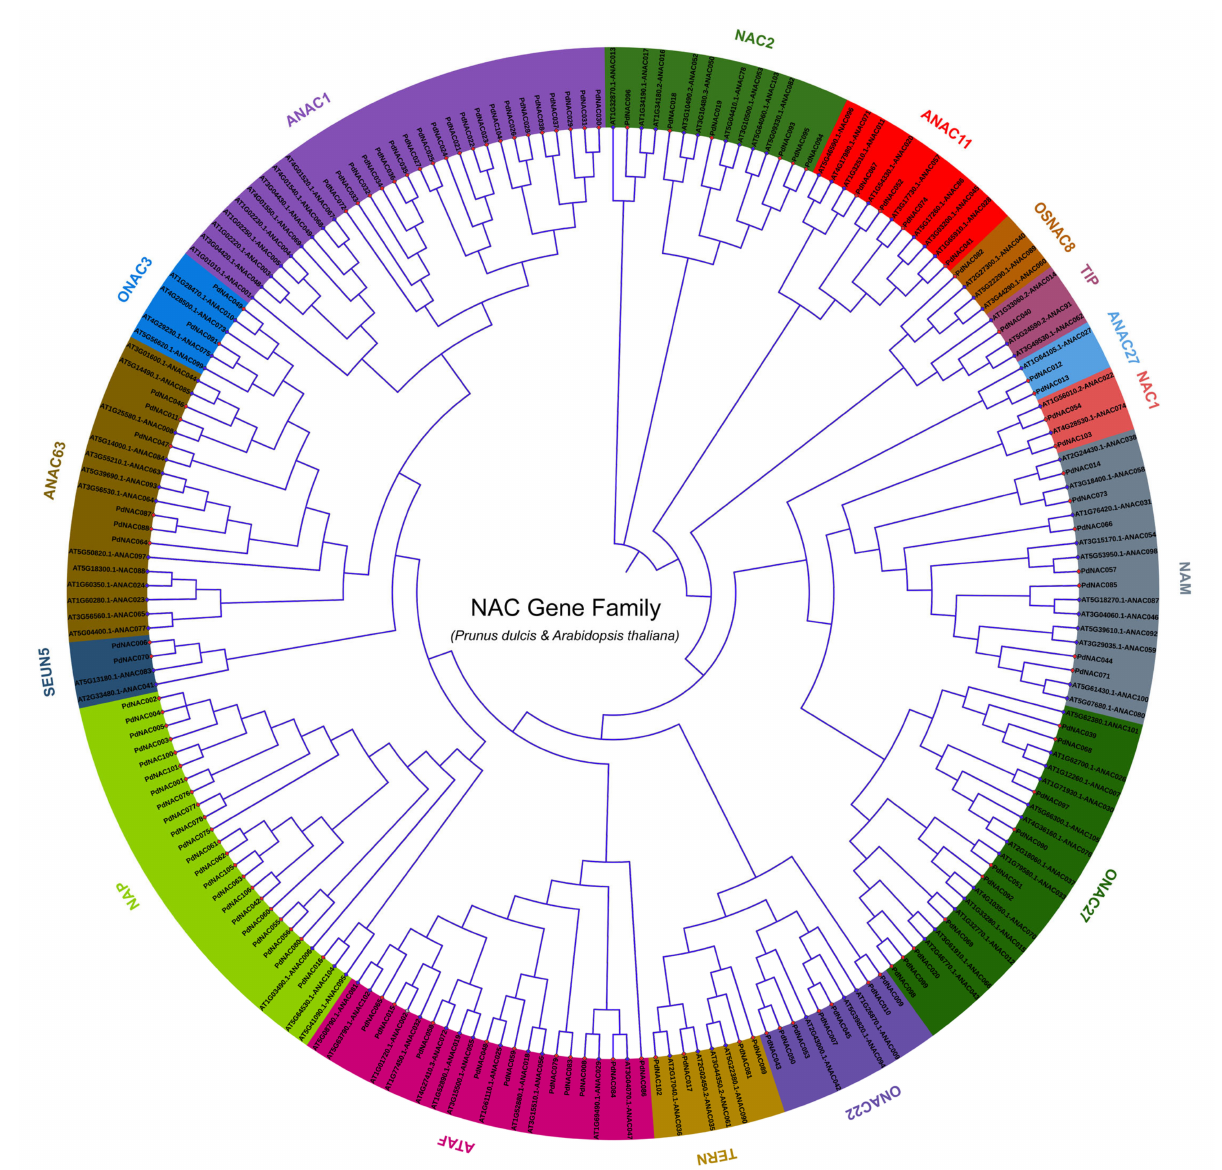
Figure 3. Phylogenetic analysis of P . dulcis and A . thaliana NAC. PdNAC and AtNAC are divided into fourteen subgroups according to the subgrouping of A.